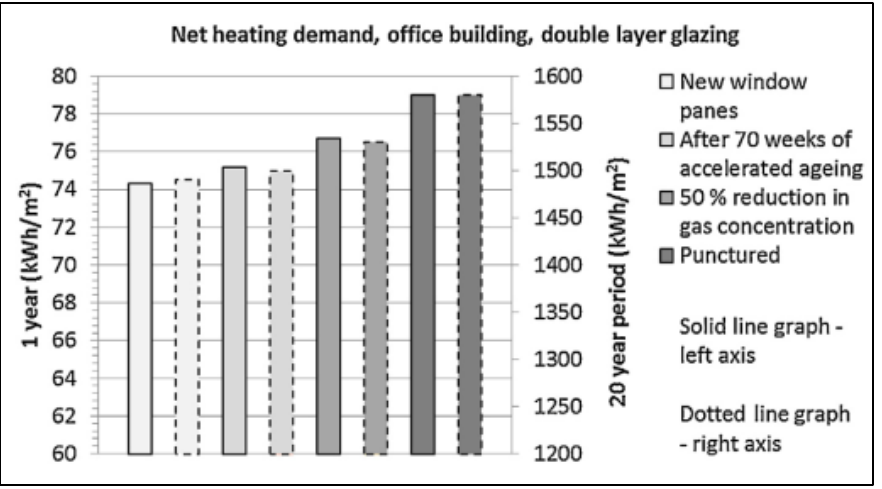
Figure 11. Net Heating Demand, Office Building, Double Layer Glazing [5].